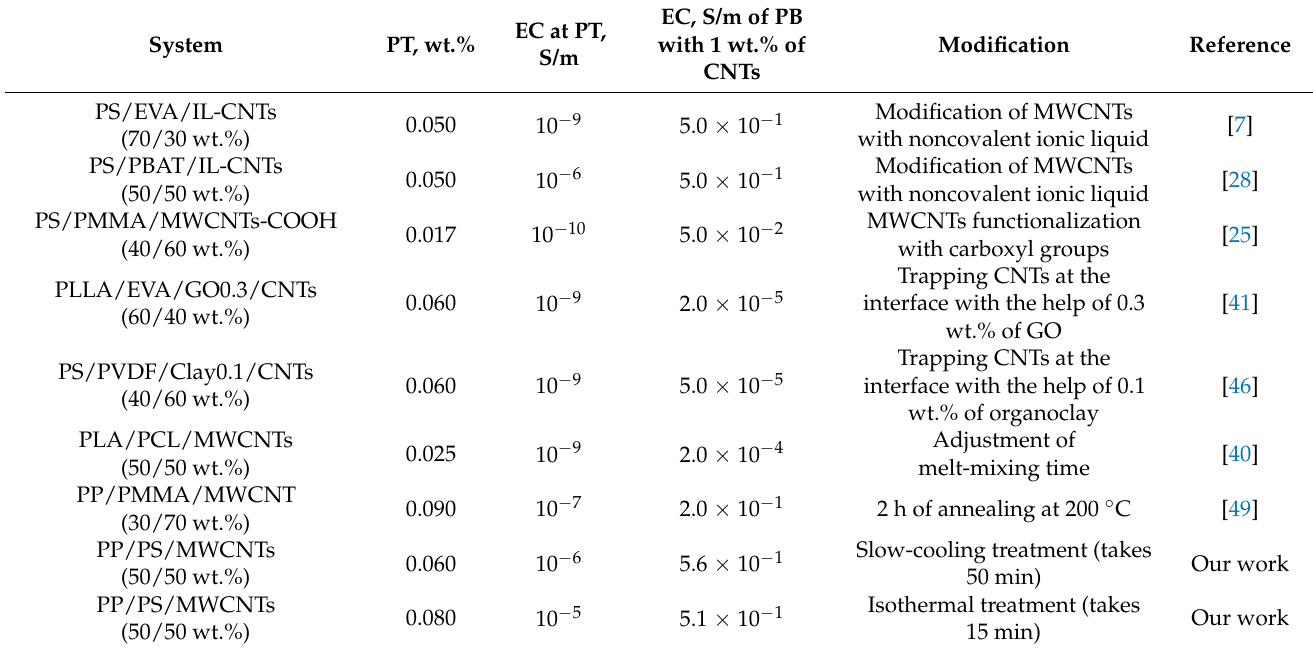
Table 2. Ultra-low PT values of CNT-thermoplastic systems achieved by different modifications and treatments. System PT, wt.%